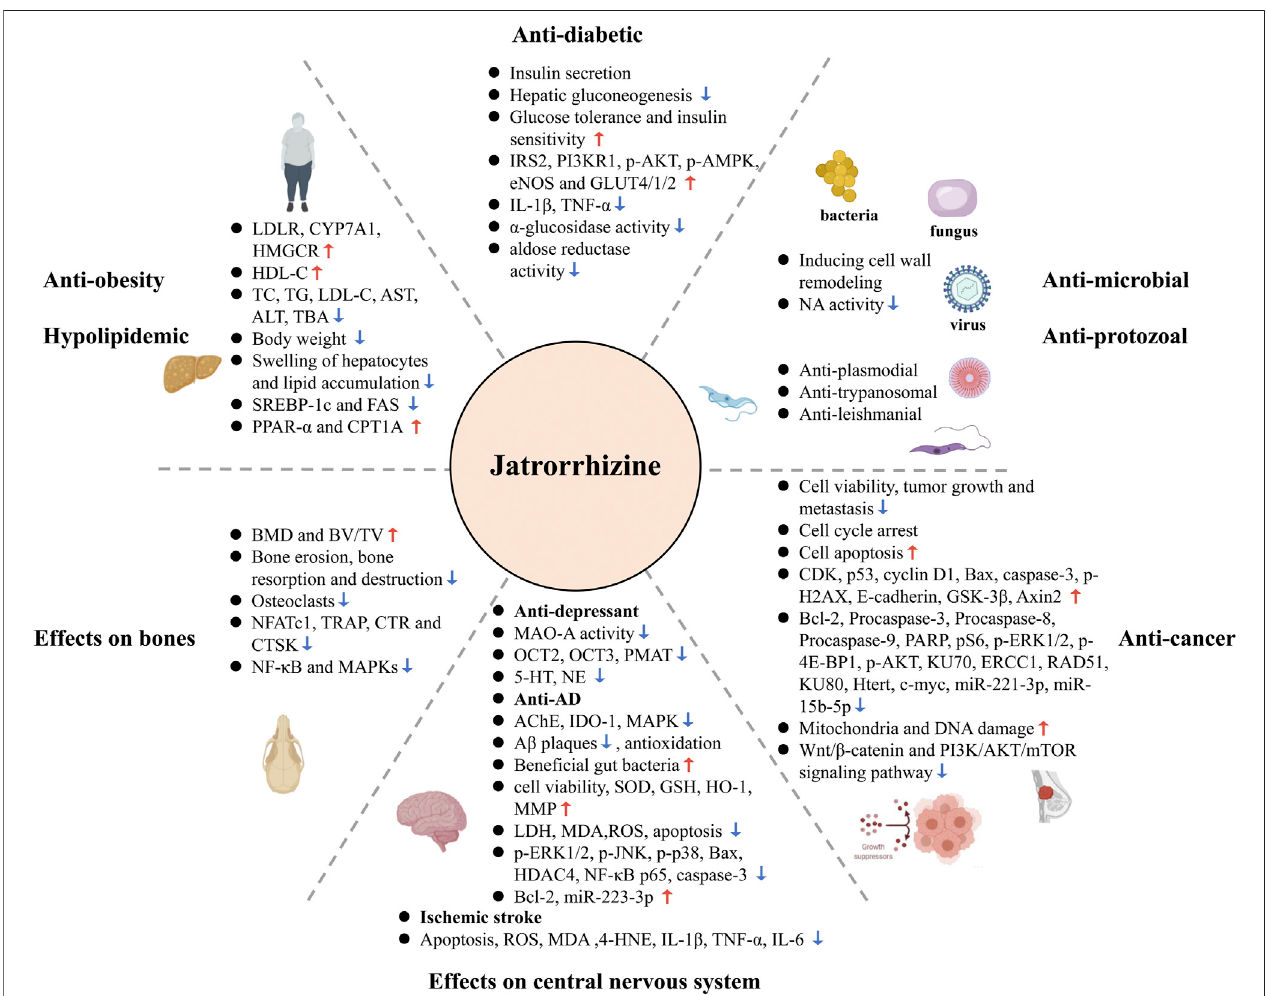
FIGURE 5 | Summary of the therapeutic potential of jatrorrhizine through multiple pathways and multiple